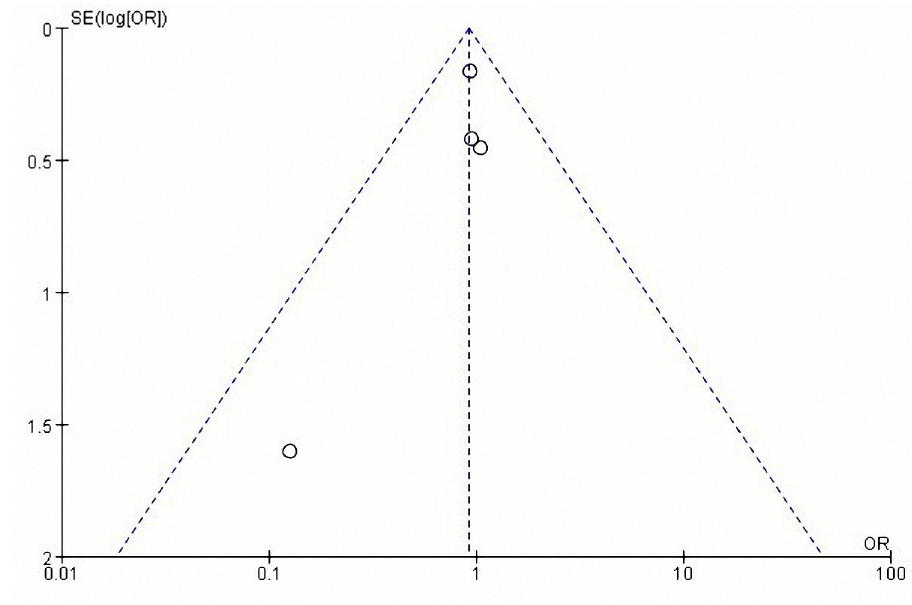
Figure 4. Funnel plot of overall postoperative complication rate in patients between RG and OG. OR, odds ratio; SE, standard error.